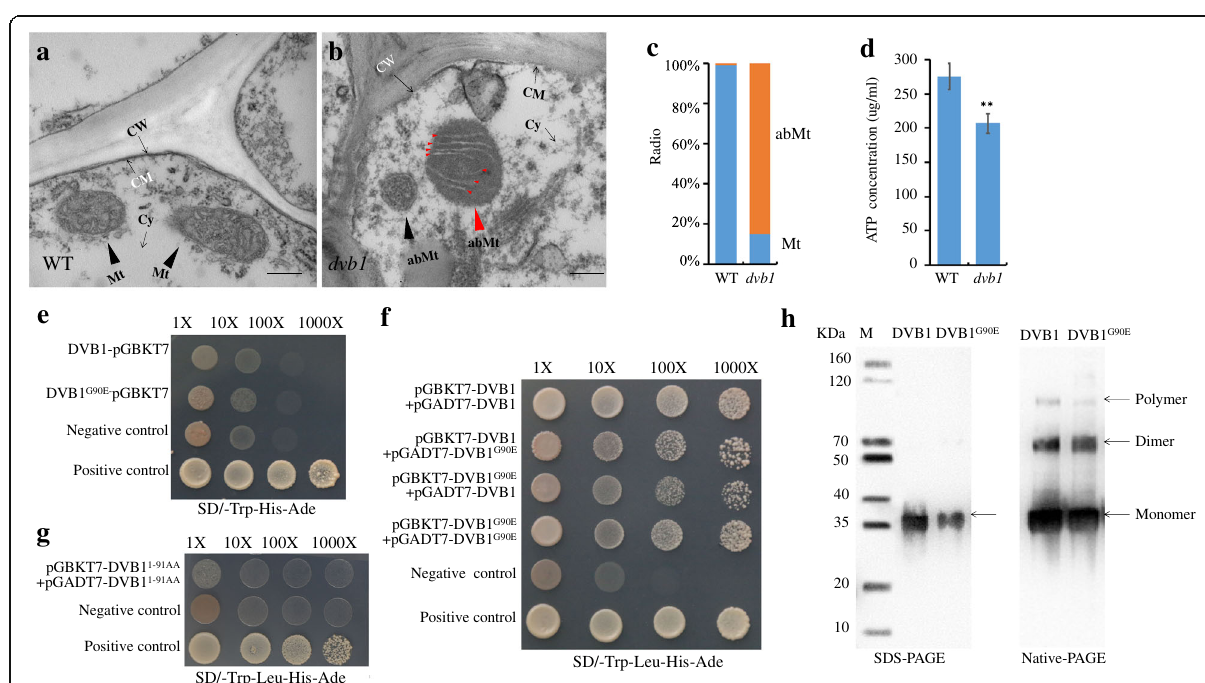
Fig. 6 Mitochondrial defect of dvb1 and dimer and polymer of DVB1 and DVB1 G90E . a , b Transmission electron micrographs of mitochondria of the wild type ( a ) and the dvb1 mutant ( b ). c Ratio of normal and abnormal mitochondria in wild type and the dvb1 mutant. d ATP content in wild type and dvb1 leaves . e Self-activation of DVB1 and DVB1 G90E in yeast cells. ( f ) Interaction with themselves and with each other of DVB1and DVB1 G90E in yeast cells. g \ Interaction with itself of DVB1 1 – 91AA in yeast cells. h Immunoblotting using anti His Tag antibodies after SDS-PAGE (left) showed DVB1 and DVB1 G90E expressed and purified from E. coli have the expected size of 34.5 kDa, and after Native-PAGE (right) that DVB1 and DVB1 G90E can form dimers and smaller degree of polymers. CW: cell wall; CM: cell membrane; Cy: cytoplasm; Mt: normal mitochondria; abMt: abnormal mitochondria; Values represent means ± SD from 6 biological samples. Asterisks indicate the significance of differences between the wild type and the dvb1 mutant as determined by Student ’ s t -test (*, 0.01 ≤ P < 0.05; **, P < 0.01). Scale bars: 500 nm ( a , b